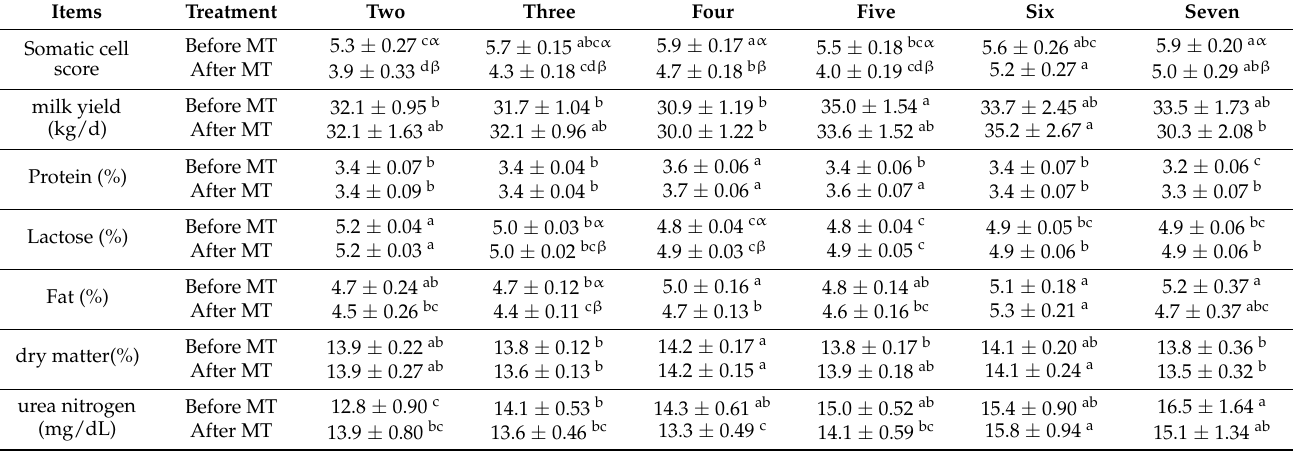
Table 5. Effects of melatonin on the DHI in cows with high SCS during different